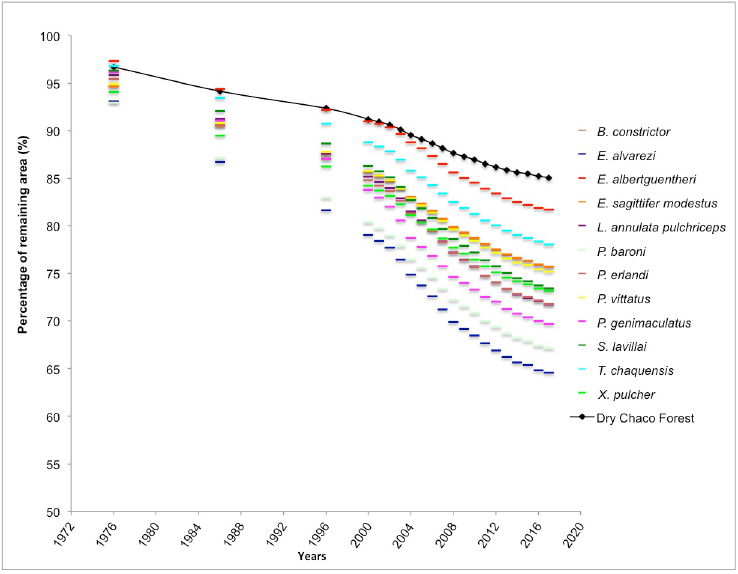
Fig 2. Percentage of the remaining distributional area for snake species and for the Argentinian Dry Chaco forest from 1976 to 2017.